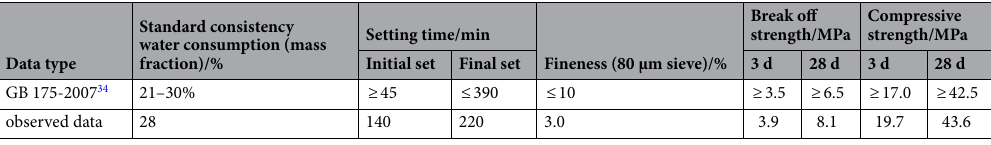
Table 1. Cement performance indicators.